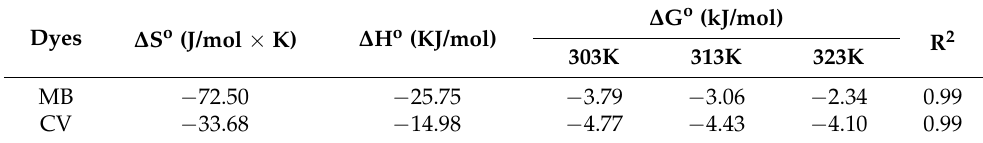
Table 5. Adsorption thermodynamic parameters for the adsorption of MB and CV by MT.